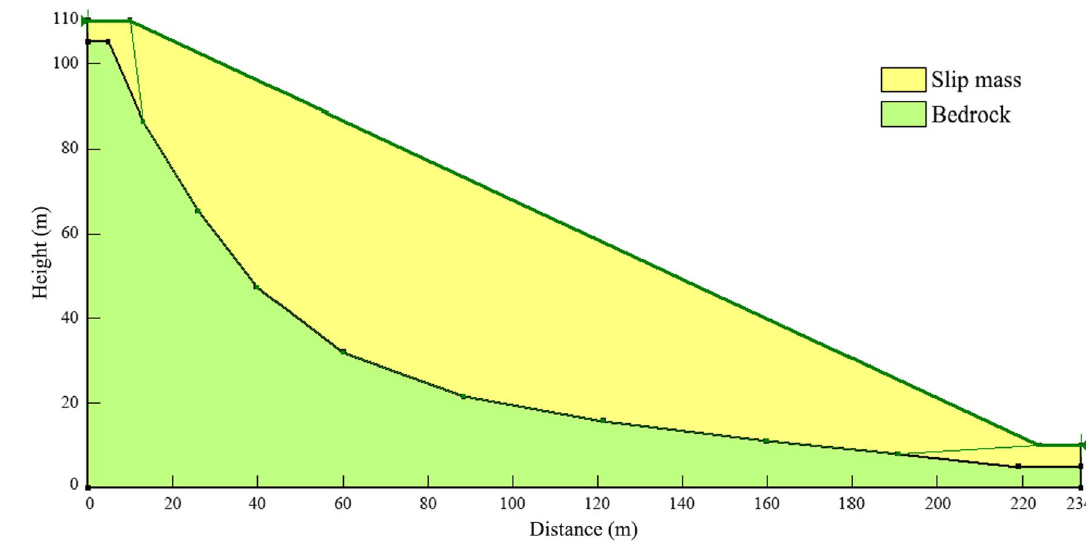
Fig. 4 A typical soil slope with slope height of 100 m and slope angle of